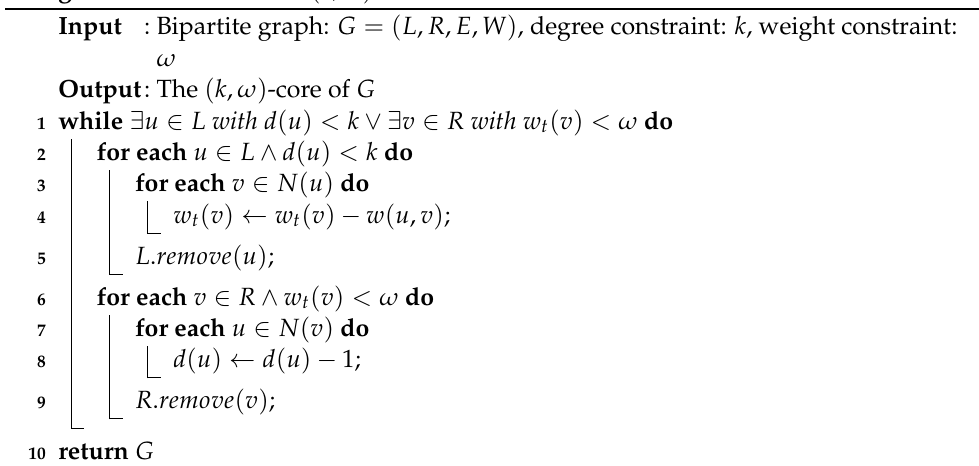
Algorithm 1 : G ENERATE ( k , ω ) -